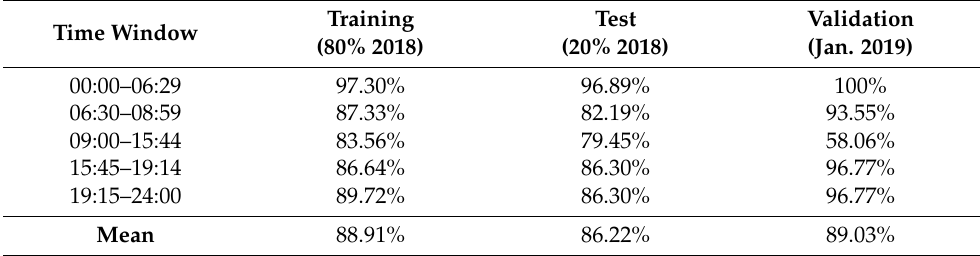
Table 3. Accuracy results from a comparison between test and validation. Time